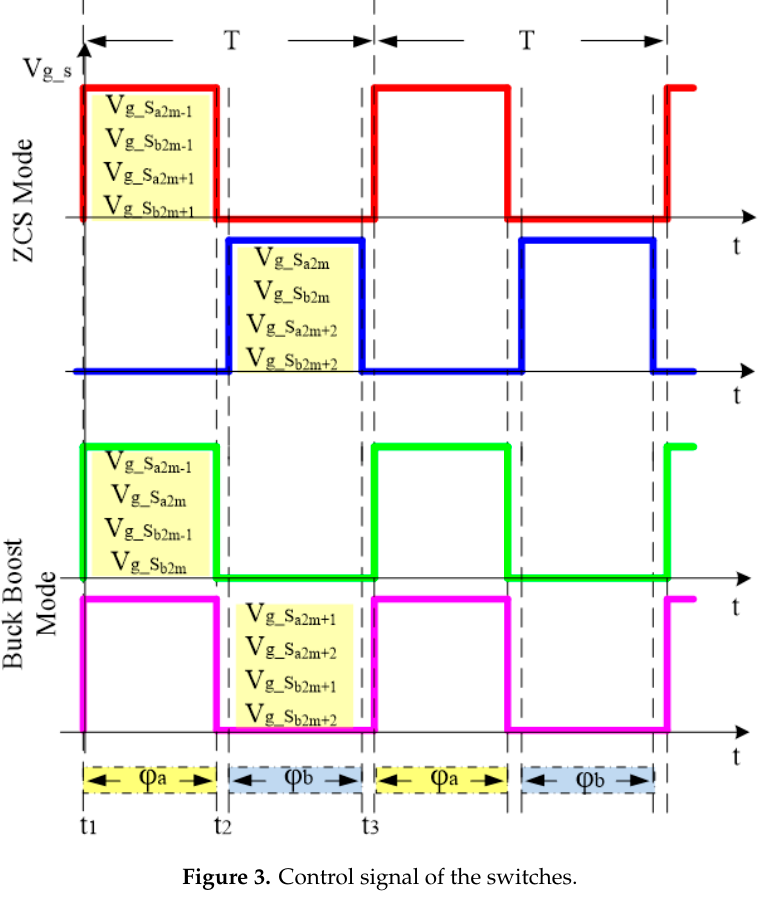
Figure 3. Control signal of the switches. Figure 4. Working principle of the proposed balancing system. ( a ) ZCS mode state I; ( b ) ZCS mode state II; ( c ) buck-boost mode state I; ( d ) buck-boost mode state II.